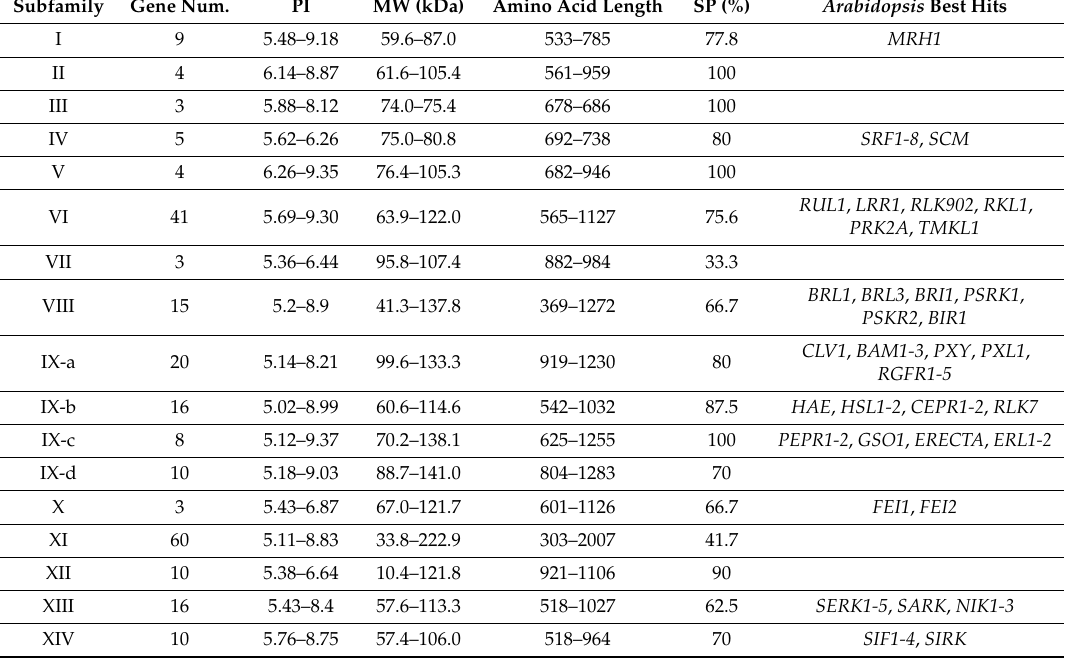
Table 1. Subfamily designation and sequence characteristics of the identified StLRR-RLK genes. Subfamily Gene